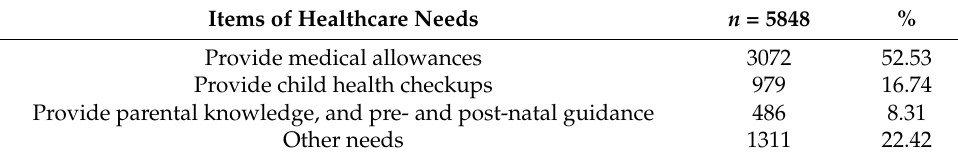
Table 1. Statistics of healthcare needs (the first choice) among the immigrant women. Items of Healthcare Needs n = 5848 % Provide medical allowances 3072 52.53 Provide child health checkups 979 16.74 486 Other